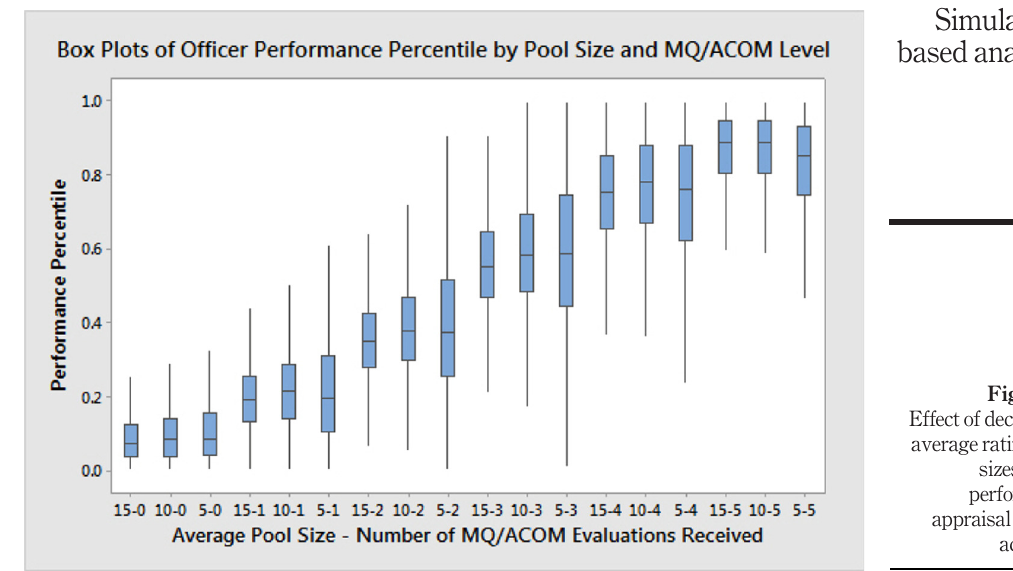
Figure 6. Effect of decreasing